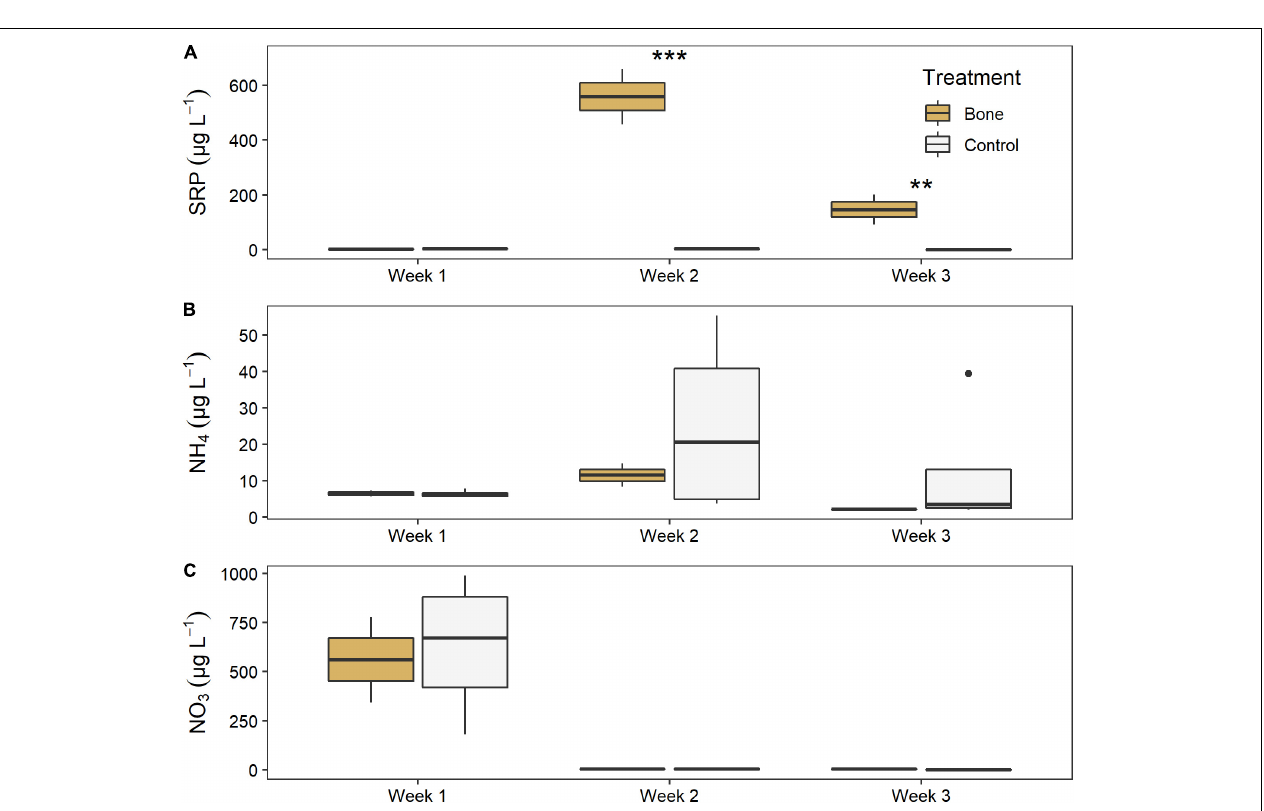
FIGURE 6 | Water column (A) soluble reactive phosphorus, (B) ammonium, and (C) nitrate in experimental streams with all gravel benthos (control treatment; n = 4) or half gravel-half bone benthos (bone treatment; n = 2) in Week 1, after equilibration and just before treatments were applied, and in Weeks 2 and 3 of the experiment. Asterisks indicate significant difference, where ** p < 0.01 and *** p < 0.001.